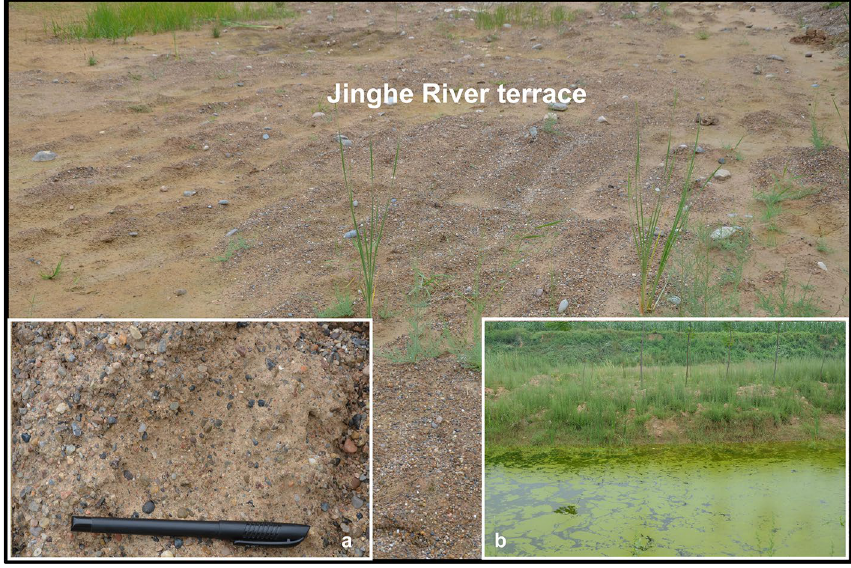
Figure 4. Photograph of the Jinghe River terrace: ( a ) alluvial deposits in the terrace; and ( b ) shallow groundwater at the surface in the terrace.